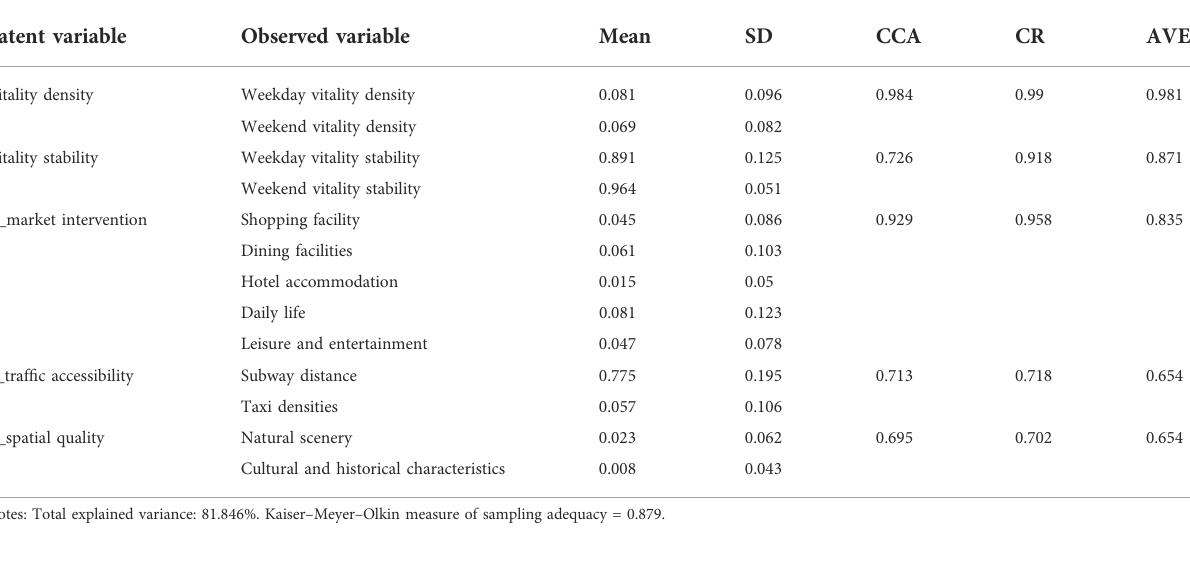
TABLE 4 Reliability and validity of all variables ( N = 1,475).